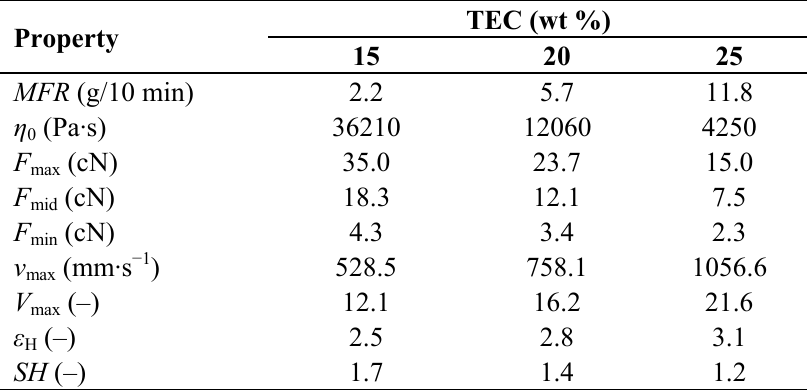
Table 4. Melt flow rate, zero shear viscosity, Rheotens characteristics, Hencky strain, and strain hardening behavior of externally plasticized CA (average values of five measurements).